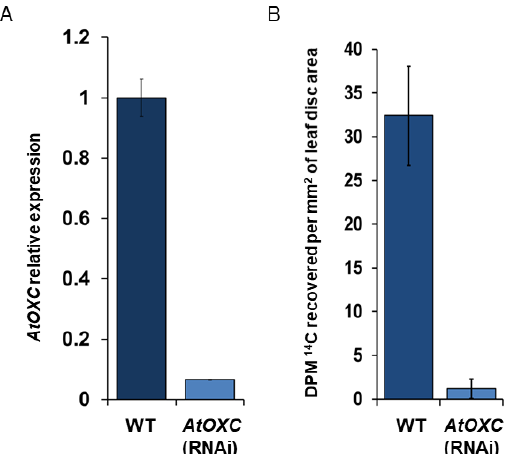
Figure 7. Measurement of oxalate degradation to CO 2 . ( A ) Relative AtOXC transcript levels in leaves of AtOXC knock-down mutant compared to WT as measured by qRT-PCR. ( B ) Radio- of AtOXC knock-down mutant compared to WT as measured by qRT-PCR. ( B ) Radiolabeled CO 2 labeled CO 2 measurements. WT and AtOXC knock-down leaf pieces were fed with 2.5 µCi of [ 14 C]- measurements. WT and AtOXC knock-down leaf pieces were fed with 2.5 µ Ci of [ 14 C]-oxalate along oxalate along with 300 µM non-labeled oxalate. The 14 CO 2 evolved was captured using 1 M KOH with 300 µ M non-labeled oxalate. The 14 CO 2 evolved was captured using 1 M KOH and the relative and the relative radioactivity was measured. radioactivity was